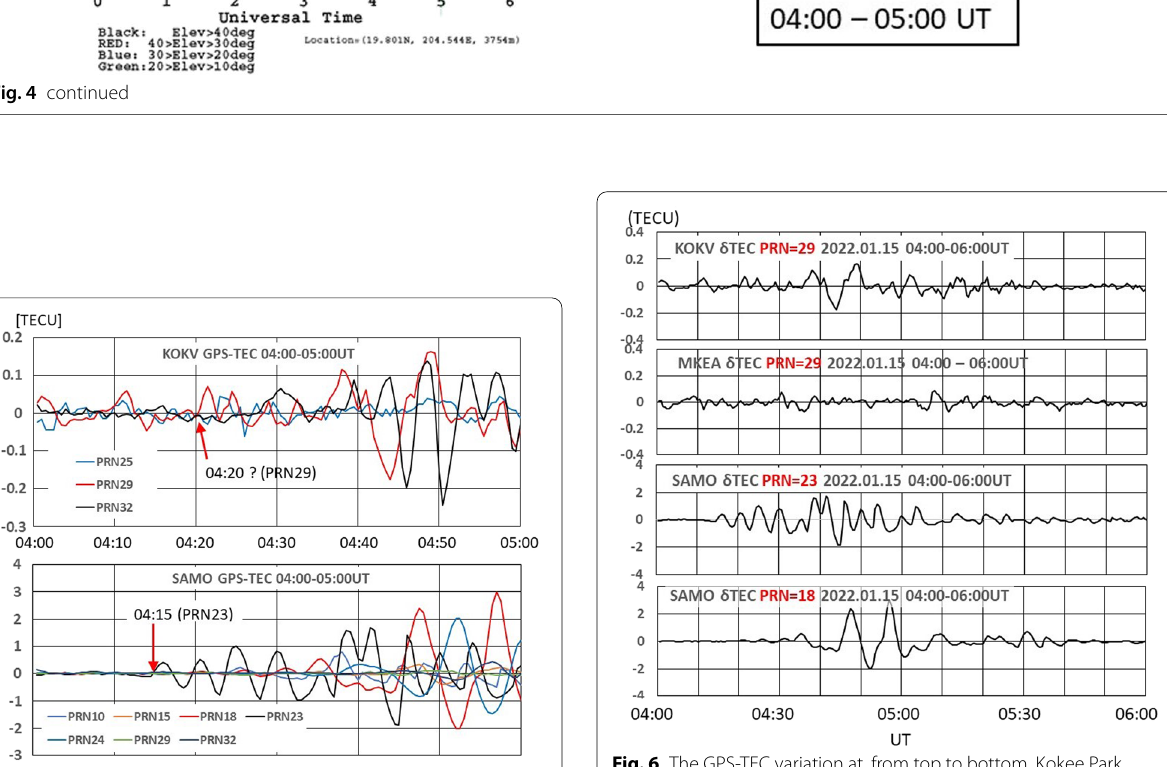
Fig. 6 The GPS-TEC variation at, from top to bottom, Kokee Park, Kauai Is. (PRN29), Mauna Kea, Hawaii Is. (PRN 29), Samoa (PRN23) and Samoa (PRN18). Note that the scale is different between the upper two panels and the lower two panels. Although the amplitude at Samoa (PRN 18) is more than 10 times larger than that of PRN = observed at Kokee Park, a variation with similar shape, i.e., two peaks, appears with time-lag about 8.5 min. The TEC amplitude observed at MKEA is smaller than that observed at